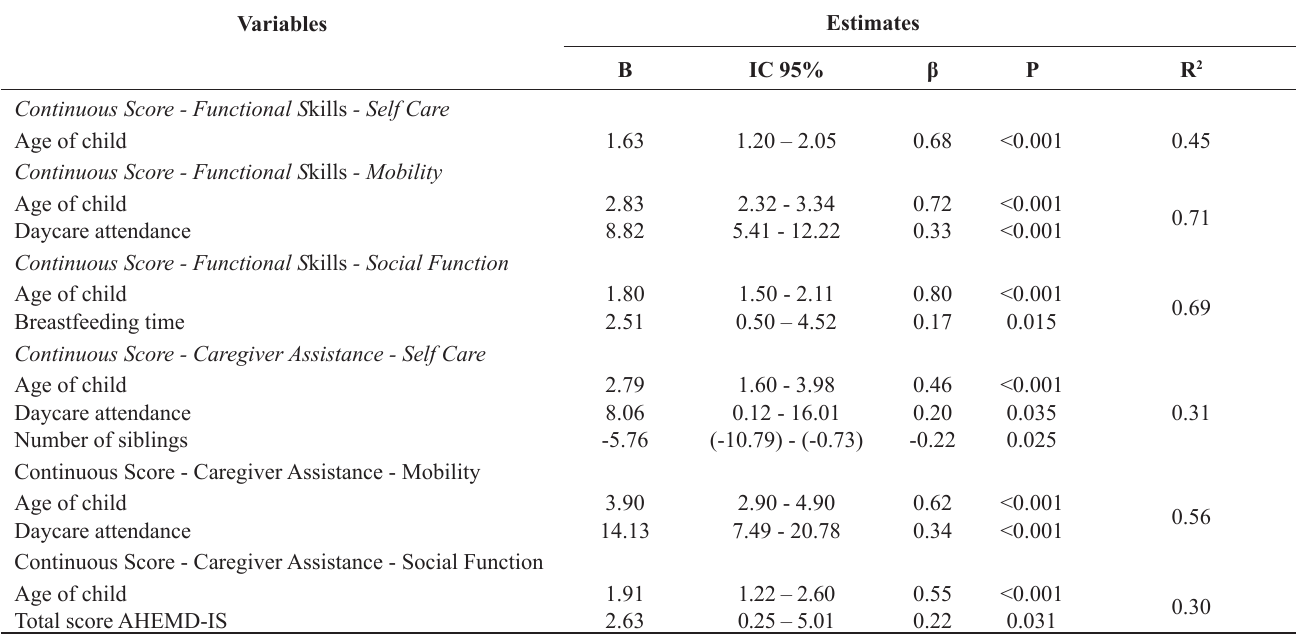
Table 4 - Multivariate regression analyzes (n = 74)